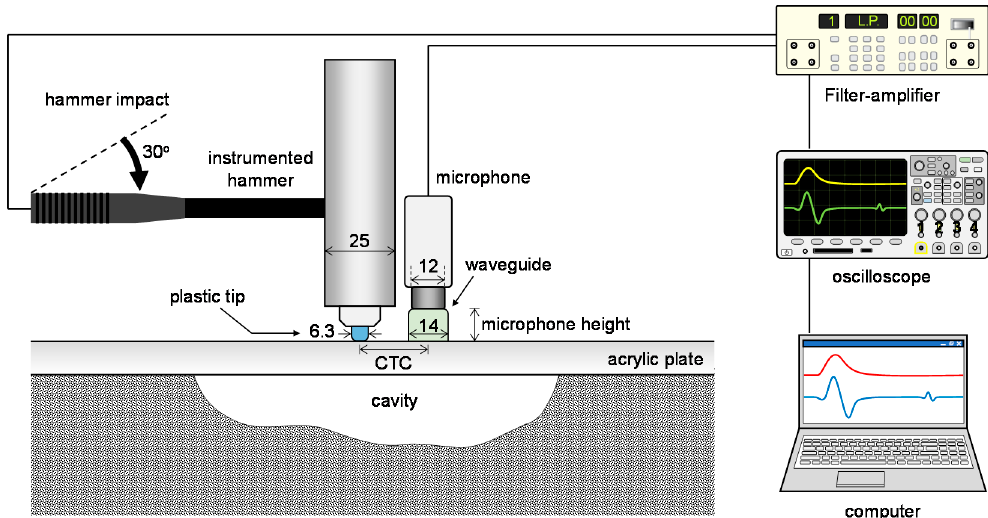
Figure 1. Measurement system. CTC denotes center-to-center spacing between hammer and microphone. Units are given in mm.